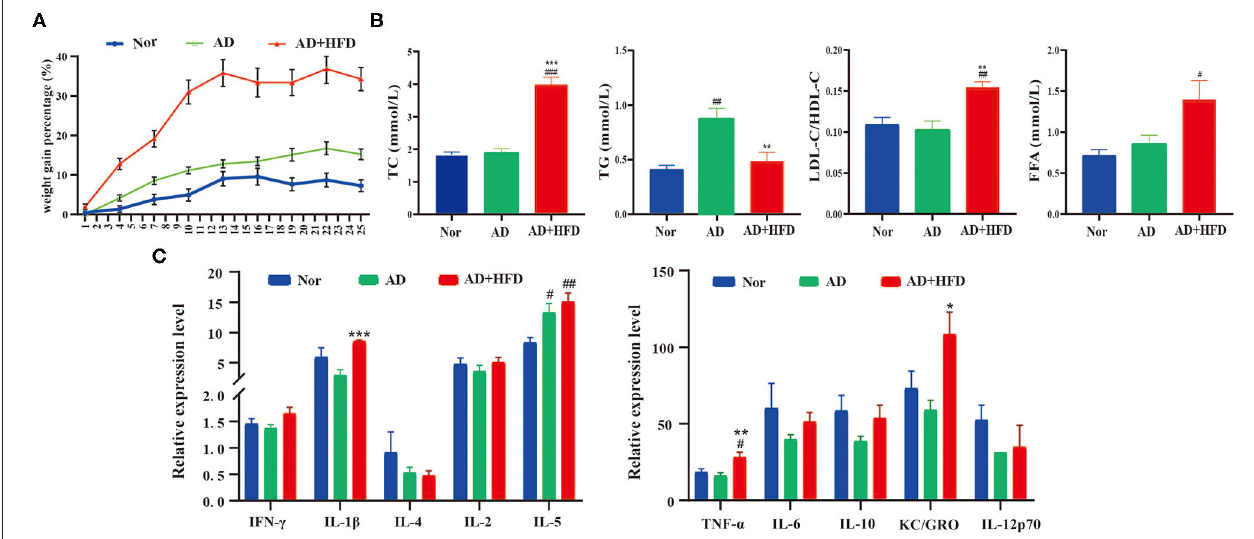
FIGURE 2 | The effect of high fat diet on APP/PS1 mice body weights, serum lipid and inflammation level. (A) The weight gain percentage with either normal diet or HFD for 6 months. (B) The level of total cholesterol, triglyceride, ratio of LDL-C/HDL-C, and FFA in mice serum. (C) Serum inflammatory cytokines were detected by